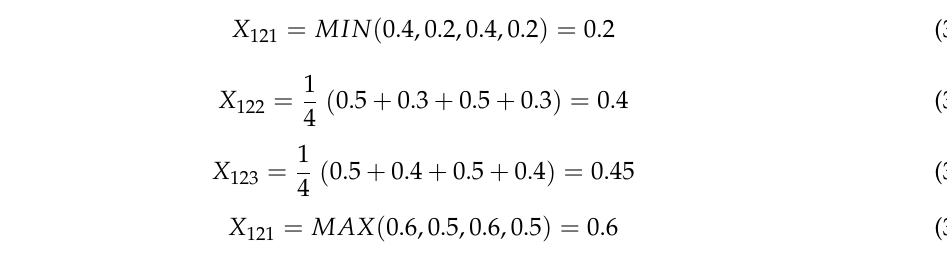
Table 14. Fuzzy evaluation matrix of alternatives according to criteria